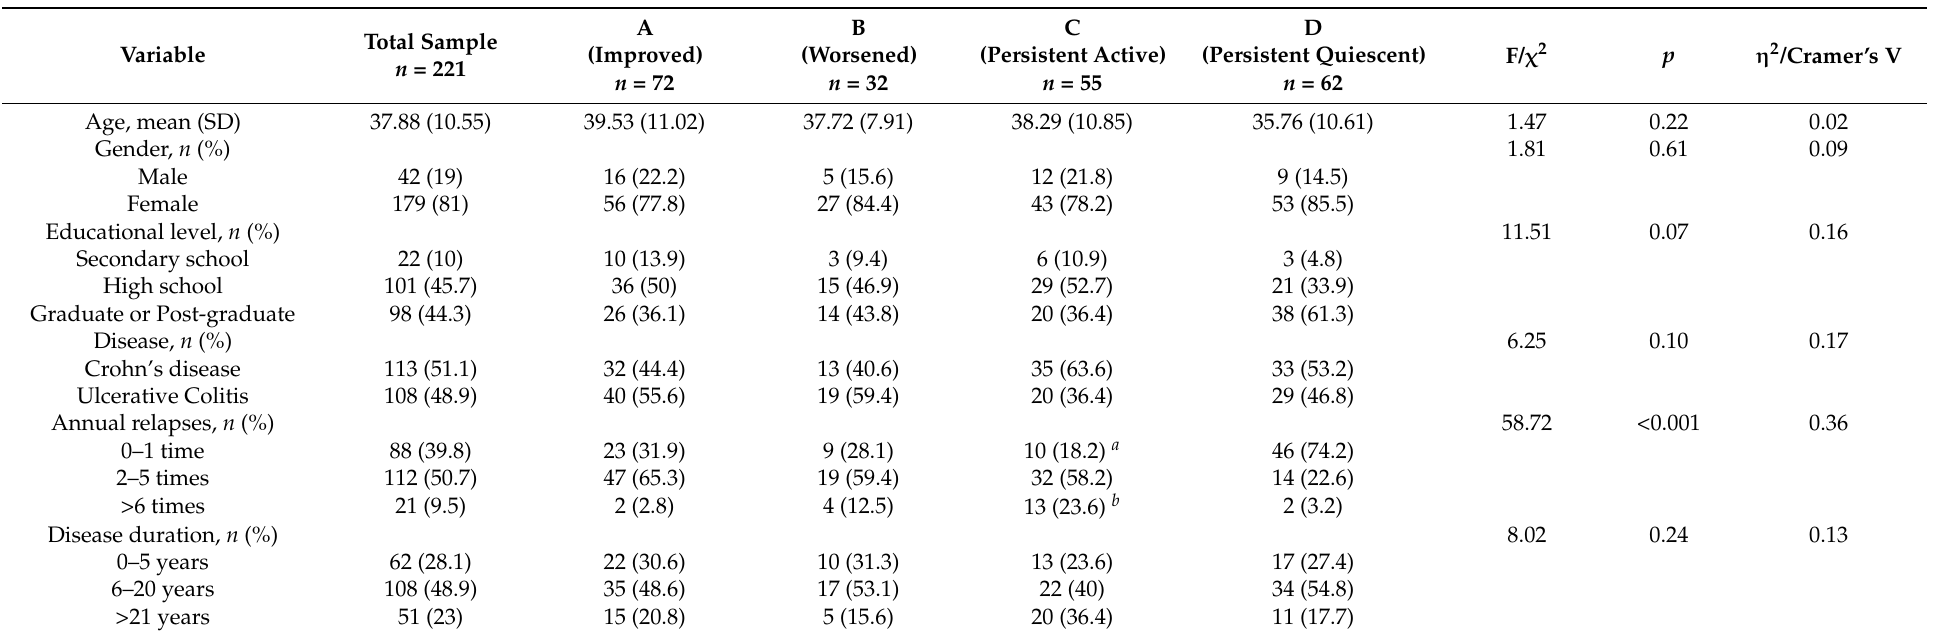
Table 2. Sociodemographic and disease characteristics of the total sample and the disease activity change-related groups.